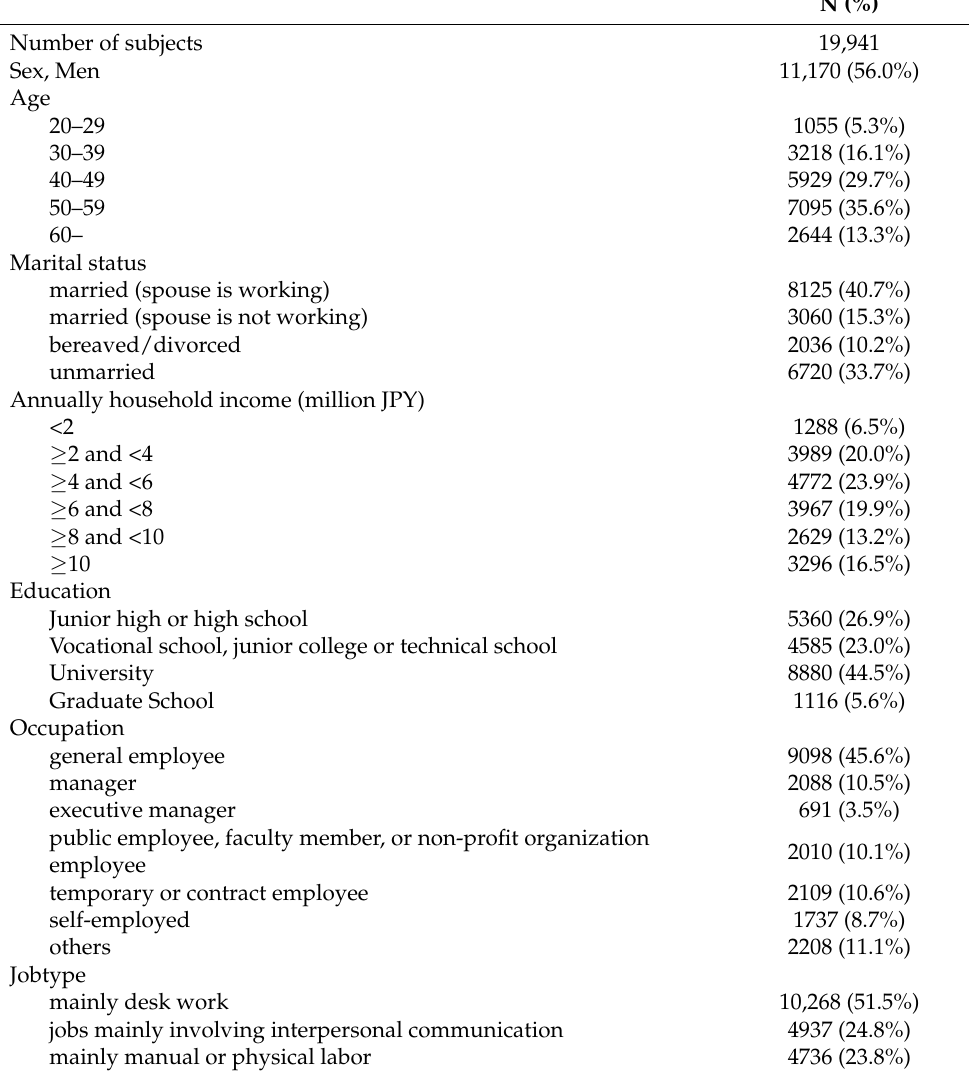
Table 1. The characteristics of the